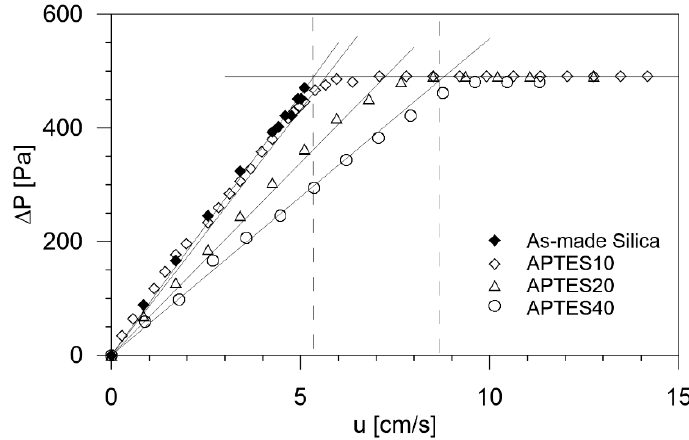
Figure 6. Diagram of the conventional fluidization tests on all samples investigated. Table 3. Conventional fluidization properties of the adsorbent particles.